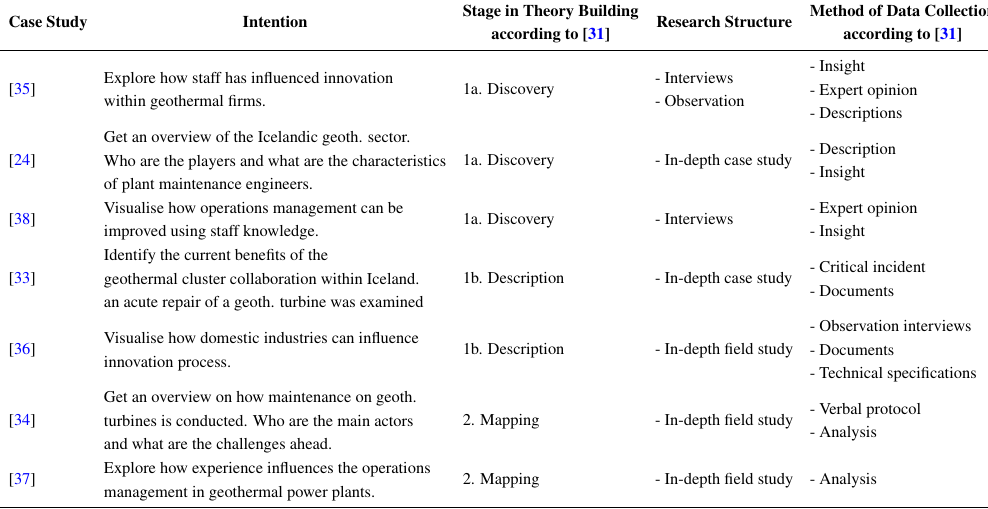
Table 2. A list of the case studies conducted, the intention of the studies and where they fit within the theory building process.